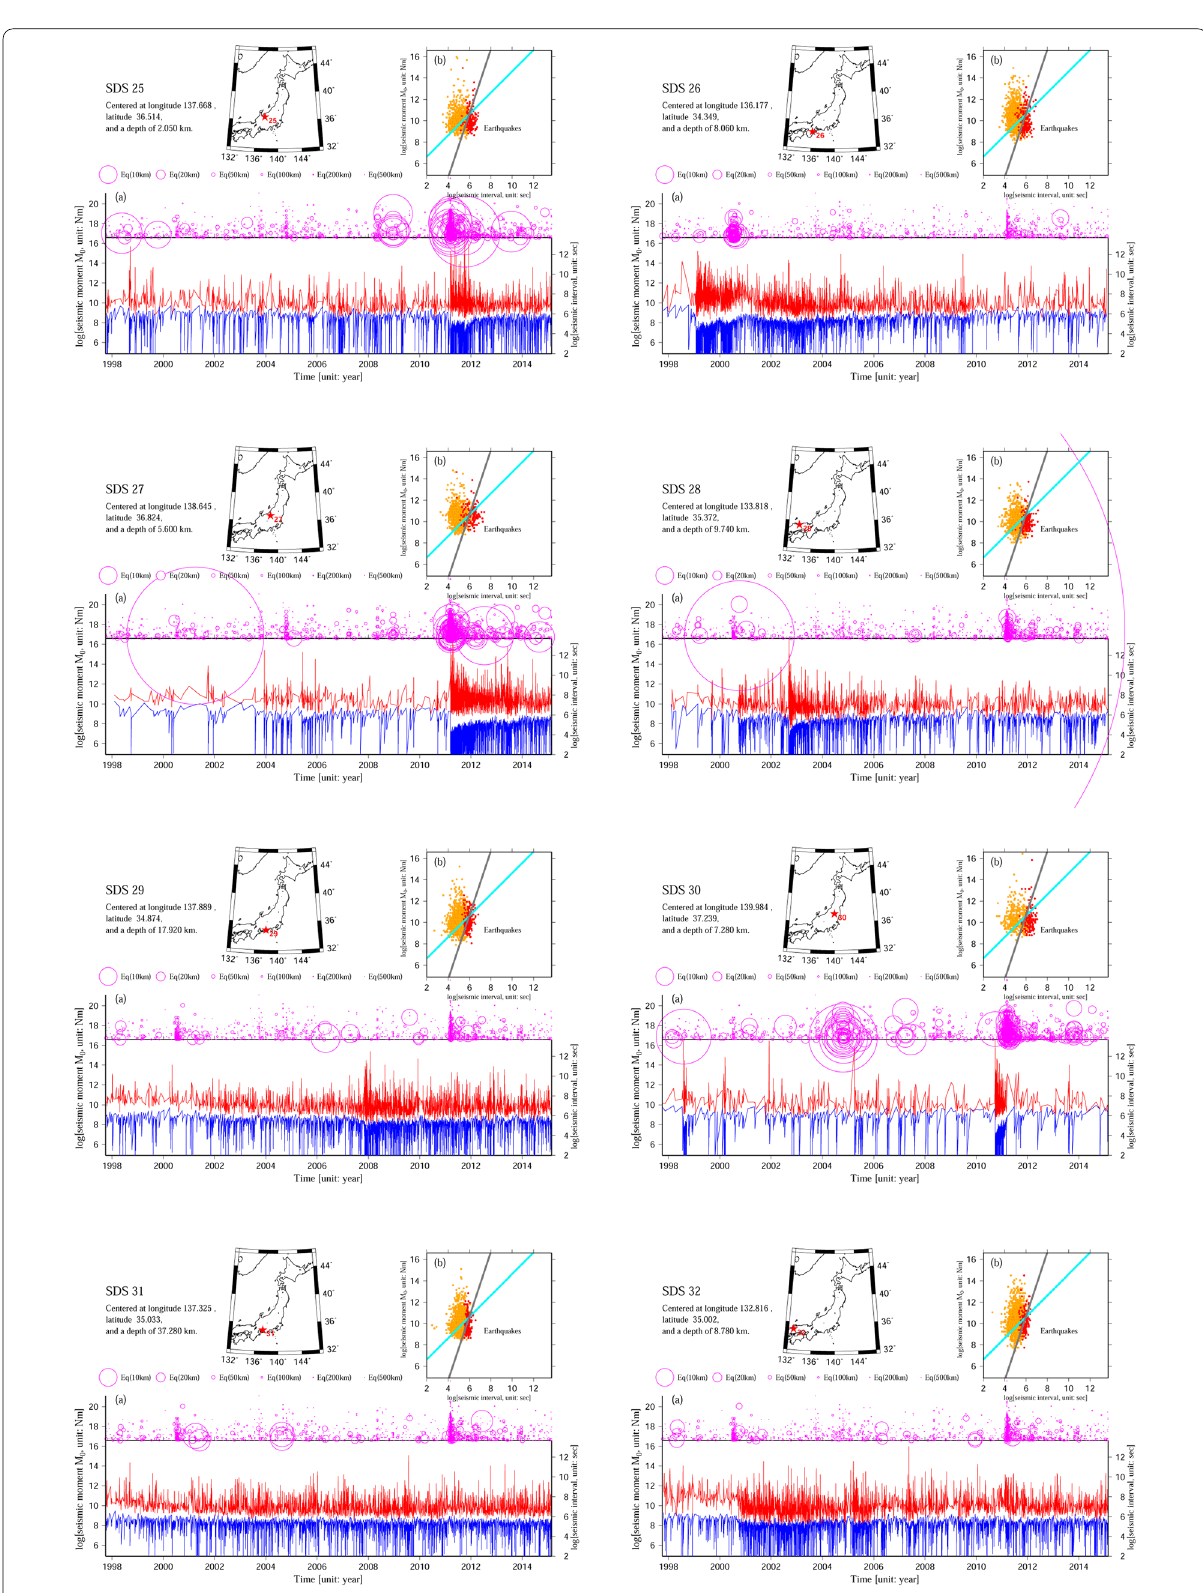
Fig. 6 Calculated results of seismic moment and seismic interval at the selected regions of seismicity density spheres